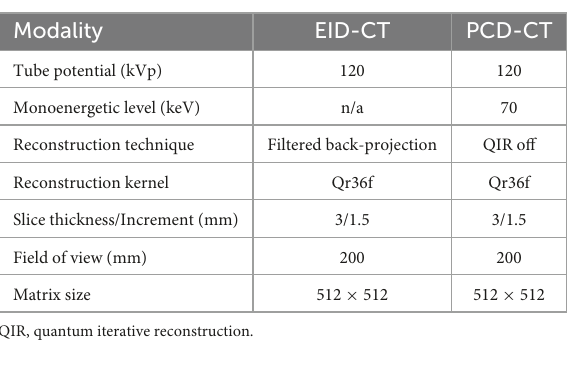
TABLE 1 CT acquisition and reconstruction parameter.